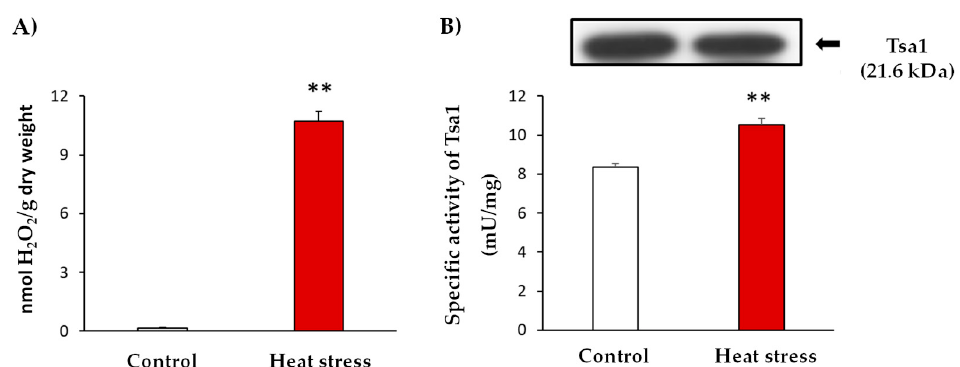
Figure 1. Characterization of heat stress at 37 °C for 1 h in yeast cultures in the exponential growth phase (A 600 nm = 0.6). ( A ). Quantification of H 2 O 2 levels in the control and stress situations expressed as nmol H 2 O 2 /g dry weight. ( B ) Specific activity and Tsa1 protein expression by immuno-blot. The control and heat stress samples (20 μ g protein per well) were subjected to SDS-PAGE. Proteins were electroblotted on PVDF membranes and then incubated with anti-Tsa1 antibody (1:500). The results are the mean ± SEM of at least three independent experiments. Statistical significance between means were analyzed by Student’s t -test and differences were significant when p < 0.001